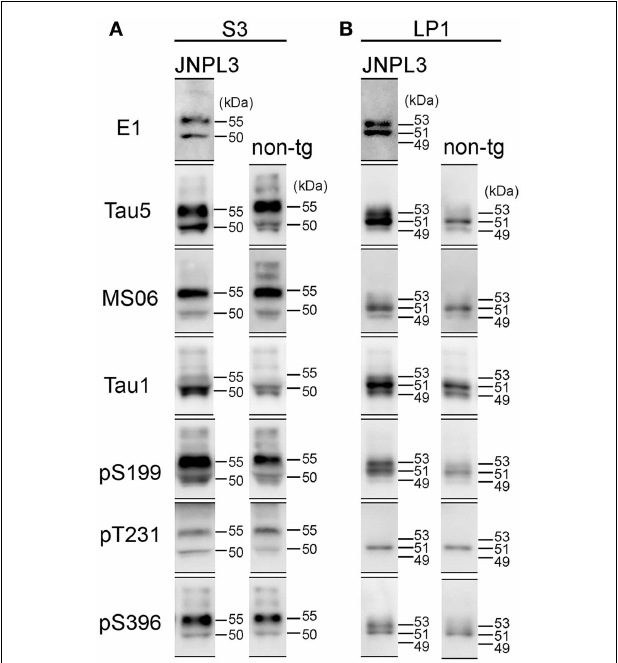
FIGURE 4 | Comparison of western blot profiles between JNPL3 and non-tg mice . (A) Representative blots of S3 fraction stained by tau antibodies (E1,Tau5, MS06,Tau1, pS199, pT231, and pS396). Molecular weights were determined by reference standard markers.Two major bands were migrated to 50 and 55kDa. ExceptTau1 antibody, the 55kDa band was more intensely stained than 50kDa band. (B) Representative blots of LP1 fraction stained by tau antibodies (E1,Tau5, MS06,Tau1, pS199, pT231, and pS396). In JNPL3 mouse, two major bands appeared with slower migration (53kDa) and faster migration (51kDa) in E1,Tau5, pS199, and pS396 blots.Two bands appeared on 49 and 51kDa in MS06 blot.Three bands (49, 51, and 53kDa) appeared inTau1 blot. Only 51kDa band appeared in pT231 blot. In non-tg mouse, 49 and 51kDa bands appeared in Tau5, MS06, andTau1 blots.Three bands (49, 51, and 53kDa) appeared in pS199 blot. Only 51kDa band appeared in pT231 and pS396